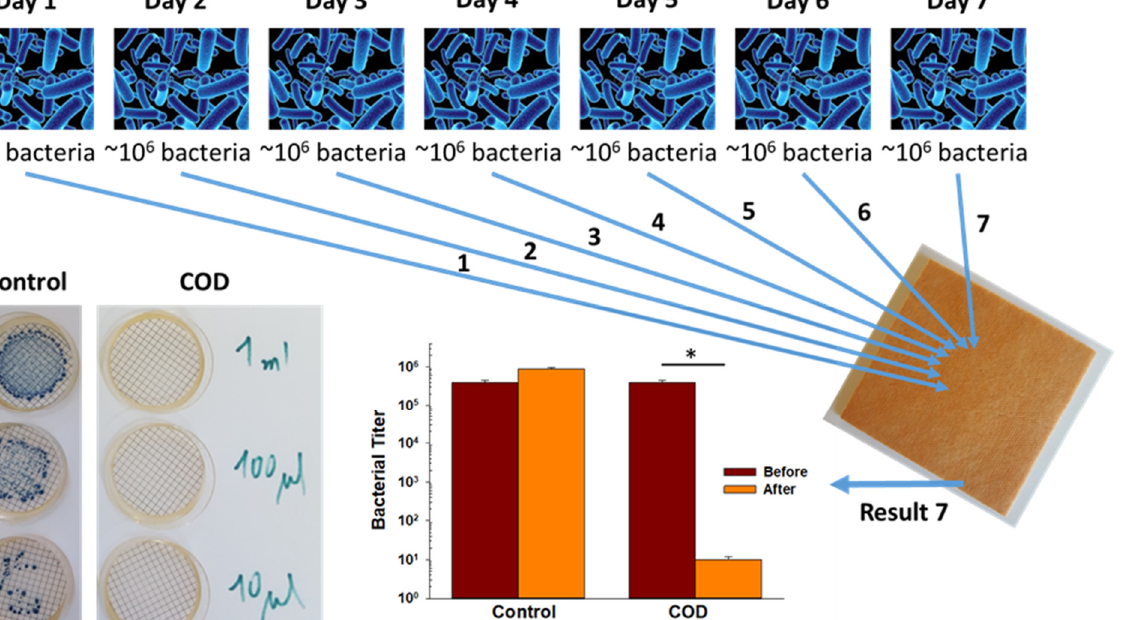
Figure 4. Potent biocidal efficacy of the test dressings after consecutive multiple bacterial exposures. Four control dressings and four test dressings were spiked with ~10 6 CFU of Klebsiella pneumoniae daily seven consecutive times. After each first six daily bacterial inoculations of the swatches, the swatches were incubated for 24 h at 37 ◦ C. After the 7th bacterial inoculation on Day 7, the